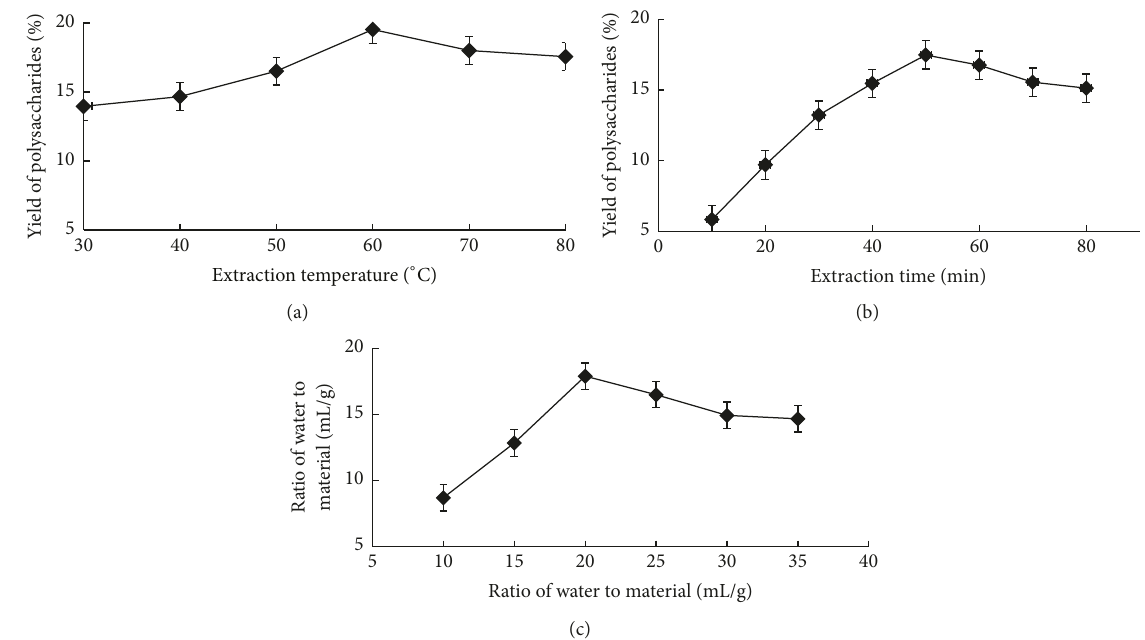
Figure 1: Effects of the extraction temperature (a), extraction time (b), and water-to-material ratio (c) on yield of DDFPs.